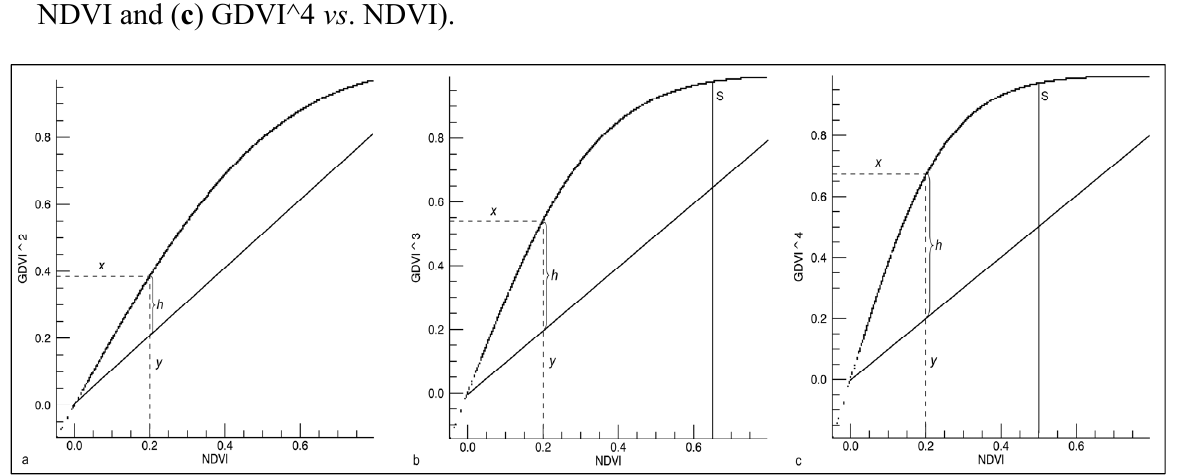
Figure 1. Characteristics of GDVI vs . NDVI (( a ) GDVI^2 vs. NDVI, ( b ) GDVI^3 vs. NDVI and ( c ) GDVI^4 vs .